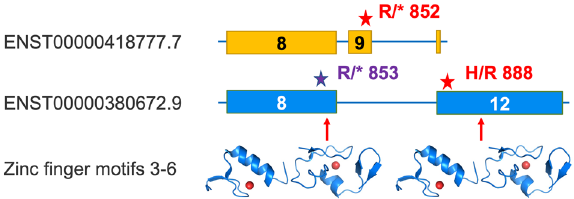
Fig. 7 Mis-annotation of a pathogenic variant in BNC2 . The fi gure represents the 3 ′ coding exons of two BNC2 transcripts (not to scale). Exon numbers (shown inside each exon) are from their position in the GENCODE v37 reference set. The position of annotated and experimental pathogenic variants (stars) is marked next to the corresponding transcripts. Exons 8 and 12 in ENST00000380672.9 (the APPRIS principal and MANE Select transcript) code for four zinc fi nger motifs. Inserted exon 9 in transcript ENST00000418777.5 leads to a frame change and a premature stop codon, which would eliminate three of the motifs. Below the two exons, the motifs are represented by the PDB structures of 3MJH and 1WJ0, mapped using HHPRED. BNC2 has two pathogenic variants in ClinVar (red stars). One is annotated in ENST00000380672.9 and produces a histidine for arginine swap at amino acid residue 888. The other is annotated exon 9 of transcript ENST00000418777.5, and is predicted to affect residue 852 of the alternative isoform. The experimentally determined pathogenic variant (purple star), which would affect both transcripts, is reported to change an arginine to a stop codon at residue 853 of the principal